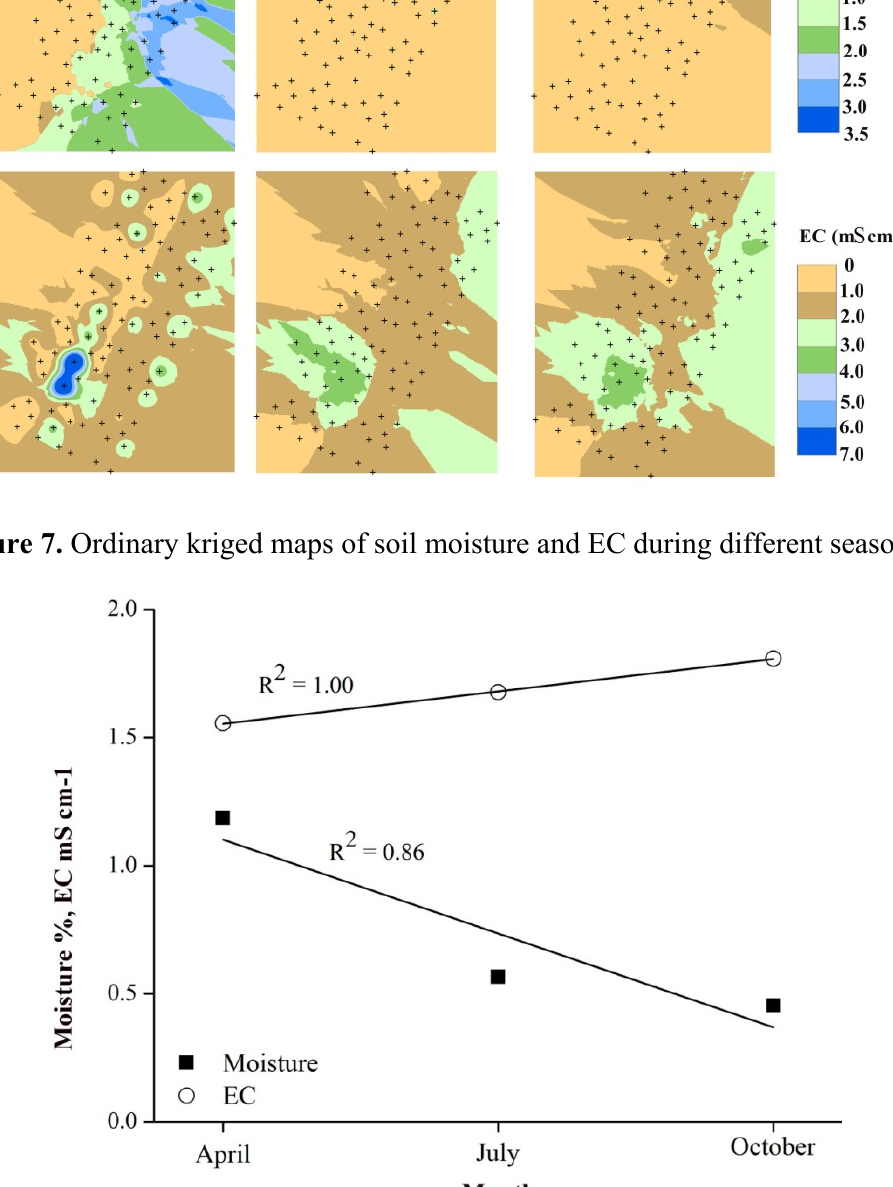
Figure 8. Functional diagram of soil moisture and EC changes in different